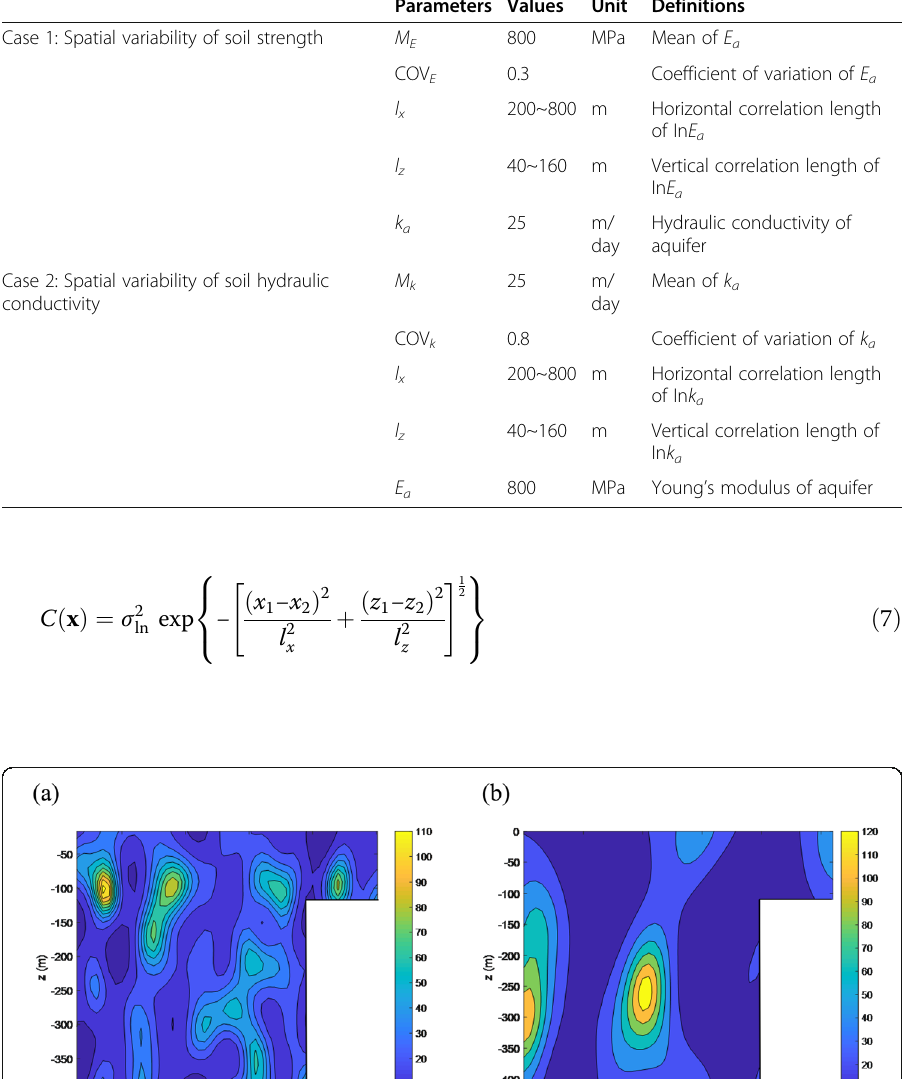
Table 2 Parameters of aquifer for probabilistic analysis Parameters Values Unit Definitions